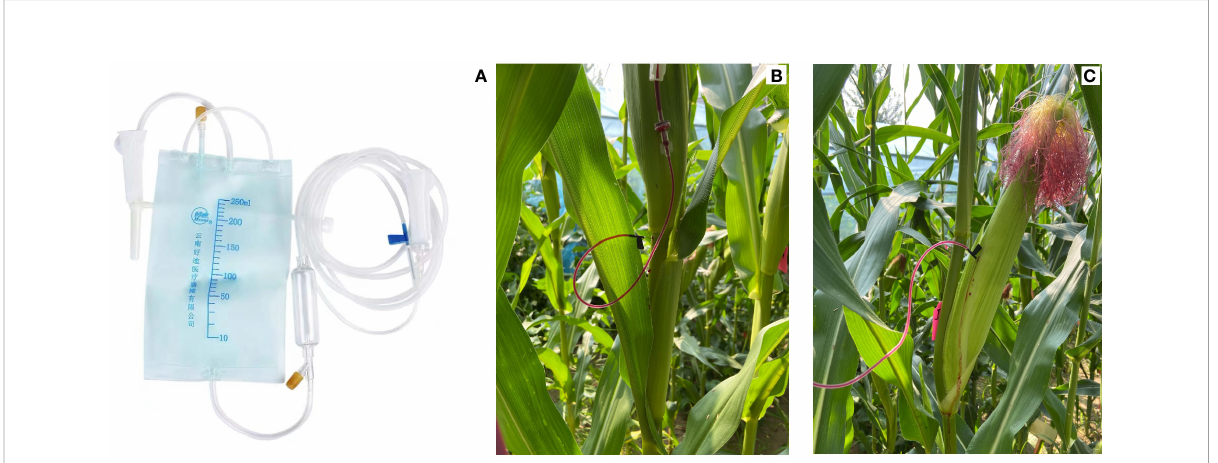
FIGURE 3 Dye movement experiments showing the infusion of the xylem-mobile dye via (A) the infusion apparatus into (B) the stem below the ear-stalk and (C) the ear